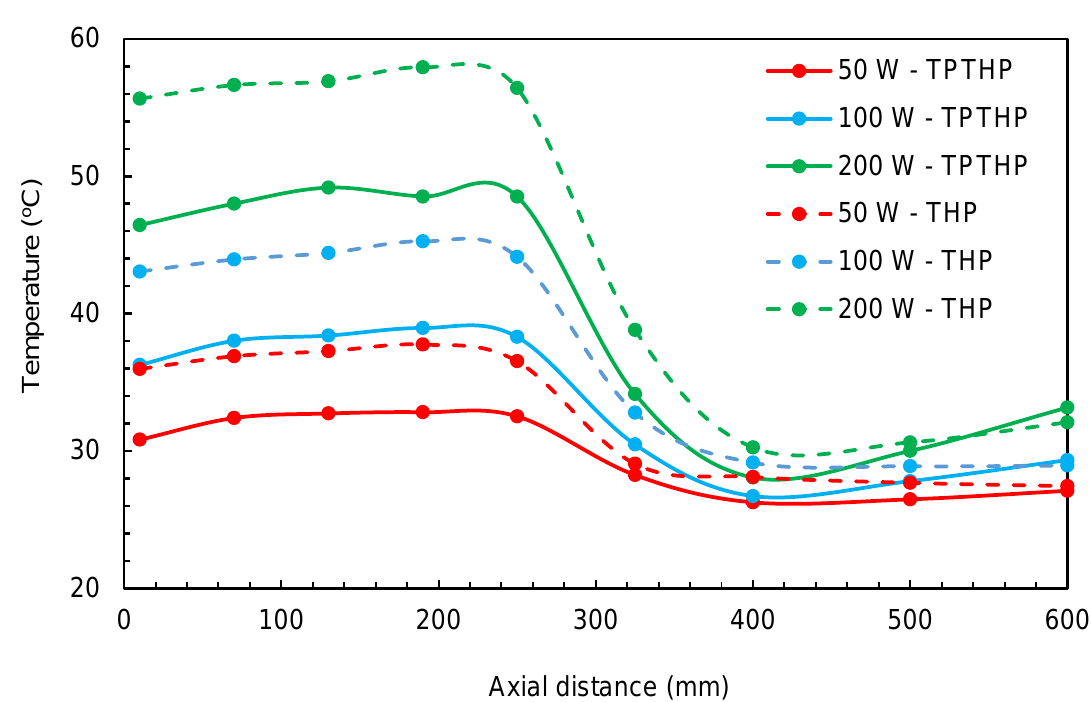
Figure 10. Comparison of temperature variation with length of both the TPTHP and THP (FR = 50%, inclination angle = 45 °C).